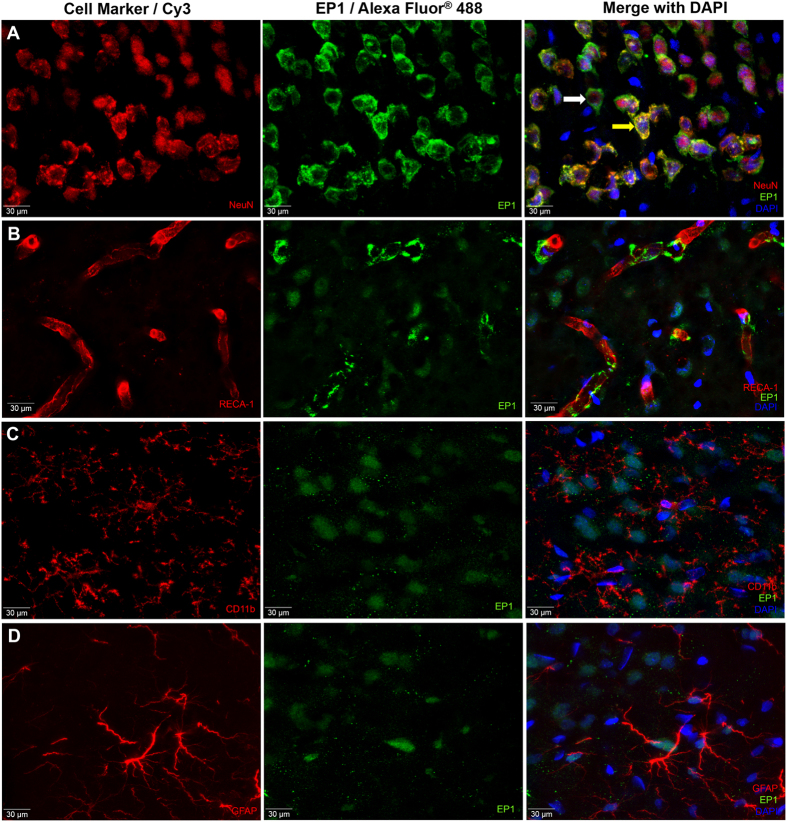
EP1 is expressed on rat neurons and endothelial cells, but not astrocytes or microglia.Free-floating double immunohistochemistry was performed using antibodies against EP1 and cell markers for neurons (NeuN), endothelial cells (RECA-1), astrocytes (GFAP), and microglia (CD11b) in sham-operated rats. All images were taken from cortical tissue. (A) NeuN (red) and EP1 (green) double-labeling shows both nuclear (yellow arrow) and extranuclear staining (white arrow) suggesting that EP1 protein may be expressed on the membrane and the nuclear envelope in neurons. (B) RECA-1 (red) and EP1 (green) double-labeling demonstrates that EP1 is expressed on endothelial cells. (C) CD11b (red) and EP1 (green) double-labeling shows apparent staining on neurons, but not on microglia. (D) GFAP (red) and EP1 (green) double labeling demonstrates apparent EP1 staining on neurons, but not on astrocytic processes.